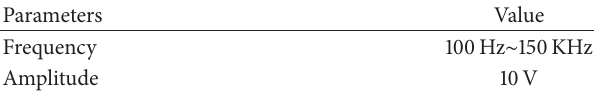
Table 1: Parameters for swept sine wave.